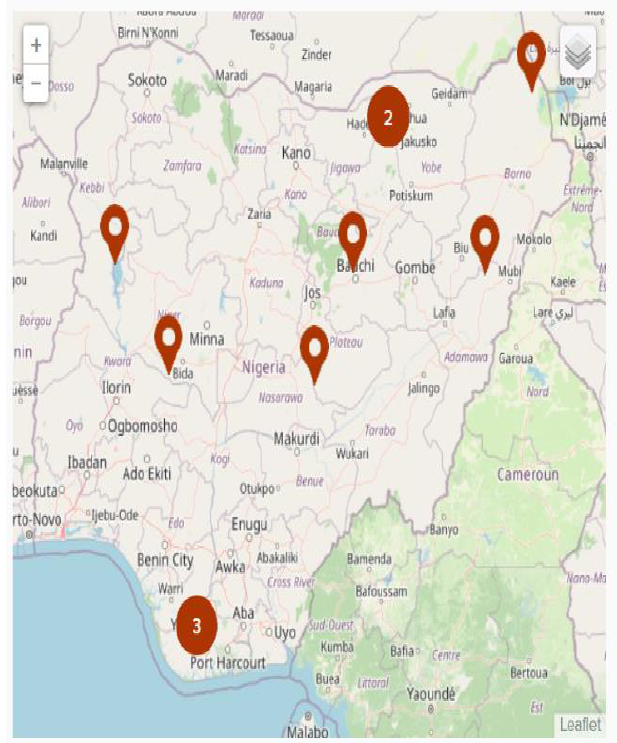
Figure 3: Nigerian Ramsar Wetlands of International